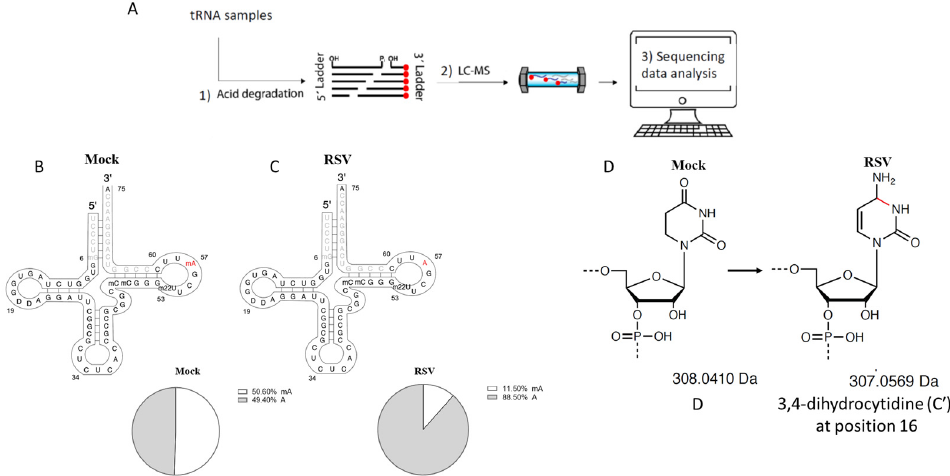
Figure 3. Identified tRNA modification changes by RSV. ( A ) Sequencing workflow. More detailed information can be found in Materials and Methods. ( B , C ) Stoichiometric changes of m1A at position 57 methylated nucleotides by RSV infection. The percentage of m1A at position 57 was reduced from 51% in the mock-infected cells ( B ) to 11% in RSV-infected cells ( C ). ( D ) The putative change of 1 Da on the pseudouritidine D by RSV.